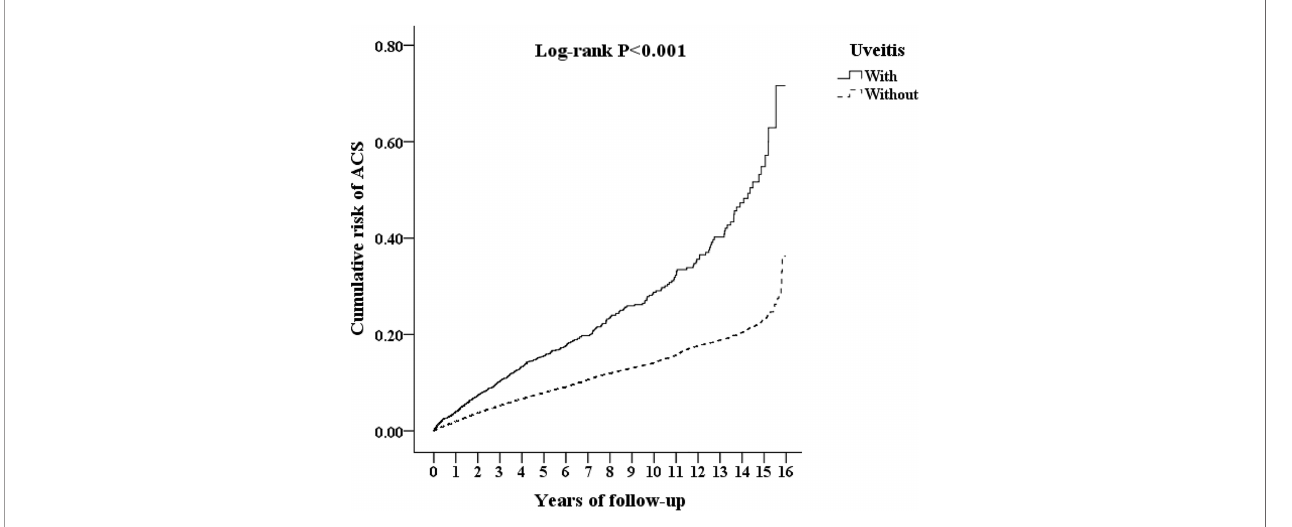
FIGURE 2 | Kaplan-Meier curves for acute coronary syndrome (ACS) in patients with ankylosing spondylitis (AS), corresponding to the uveitis and non-uveitis groups. Line represents the uveitis group and dotted line represents the non-uveitis group.